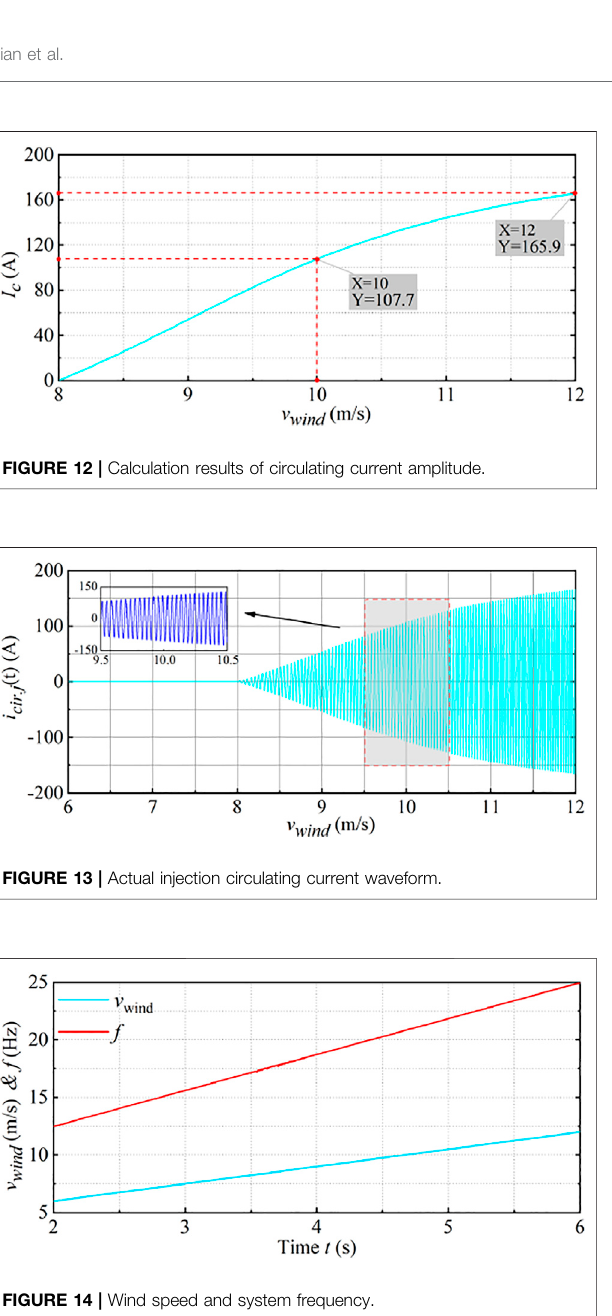
FIGURE 14 | Wind speed and system frequency.